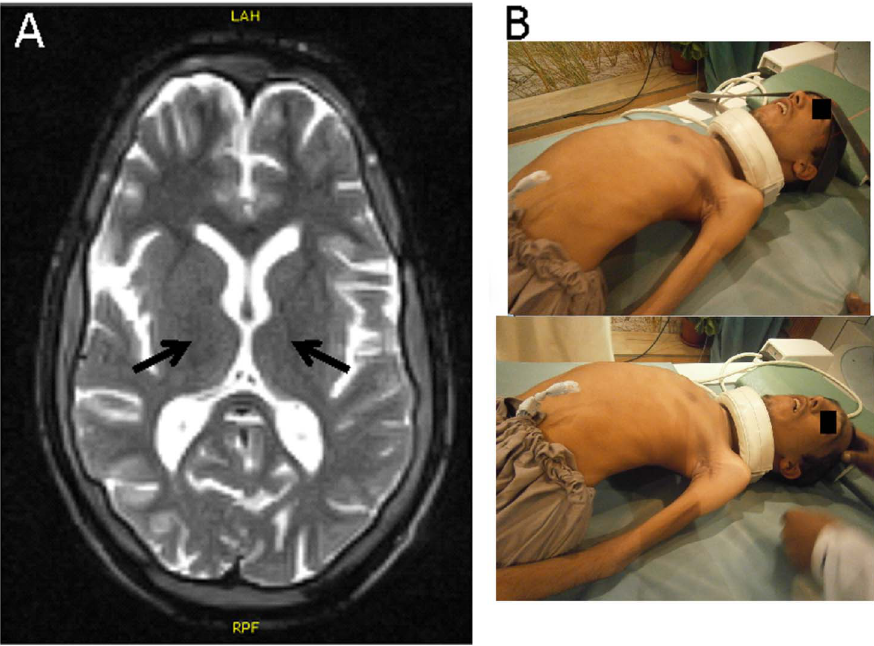
Figure 1. Patient characteristics. a) MRI brain axial T2 weighted sequence showing thinning of the corticospinal tracts (black arrows indicating corticospinal tracts) and b) photographs of one of the patients (IV- 4) showing severe